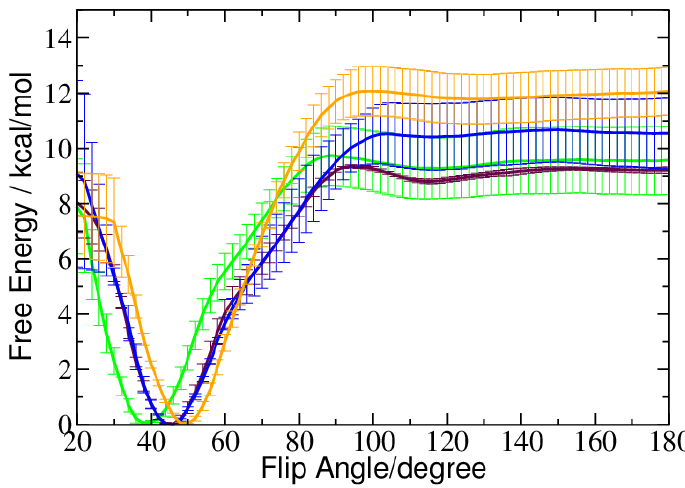
Figure 4. Free energy profile of the base flip for 5-methyl-cytosine (green), 5-hydroxymethyl-cytosine (maroon), 5-formyl-cytosine (blue) and 5-carboxyl-cytosine (orange). The pseudo dihedral coordinate is illustrated in Section